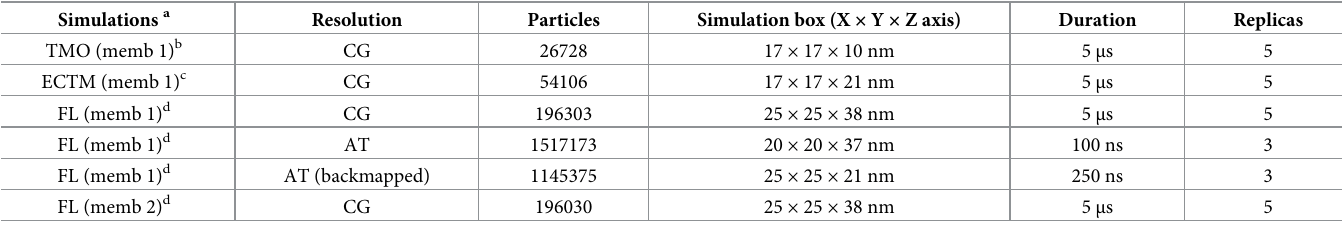
Table 2. Summary of simulations conducted in this study. Simulations a